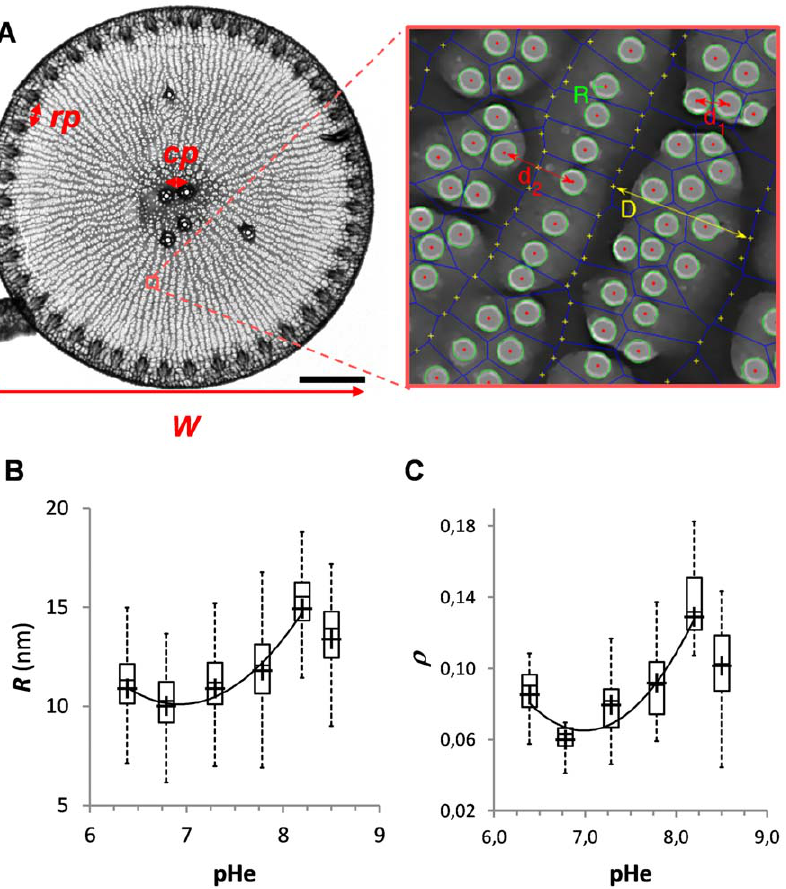
Figure 5. Influence of the environmental pH on valve morphometry. ( A ) TEM image of a valve showing the different traits measured: valve width ( W ), number ( N ) and distance ( cp ) between the fultoportulae present in the central region, and distance between rimoportulae ( rp ). Scale bar: 5 m m. The right panel corresponds to a higher magnification (64,000 6 ) showing an array of pores and the computed Voronoi diagram ( dark blue lines ) (Methods S1). We measured pore radius ( R ), the average distance between two adjacent pores ( d1 ), the width of groups of pores, also known as semi-continuous cribrum ( D ), and the width of radial ribs ( d2 ). ( B ) Boxplot showing variations in pore radiuses ( R ) (971 # n # 3551) as a function of external pH (pHe). ( C ) Boxplot showing the influence of pHe on overall valve porosity ( r ) (7 # n #